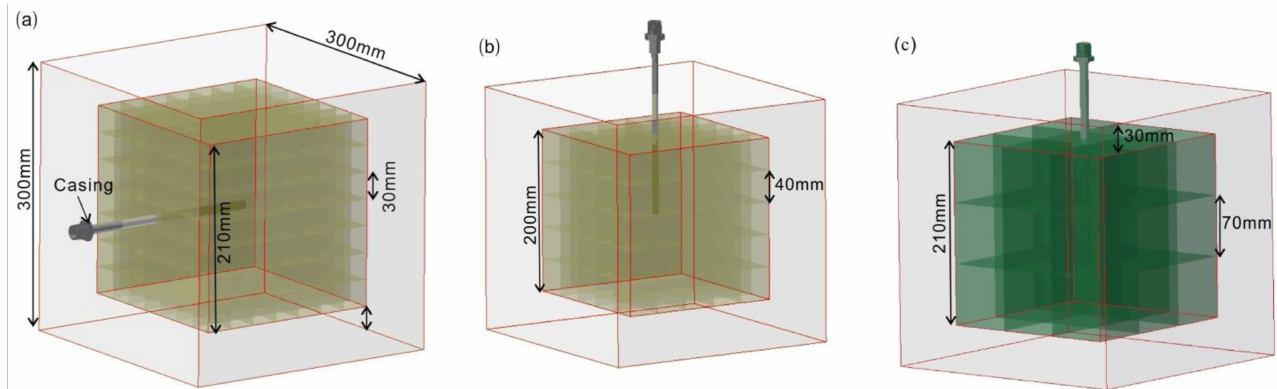
Figure 4. Schematic of model blocks with different natural fracture densities: ( a ) dense natural fracture model, ( b ) medium natural fracture model, and ( c ) sparse natural fracture